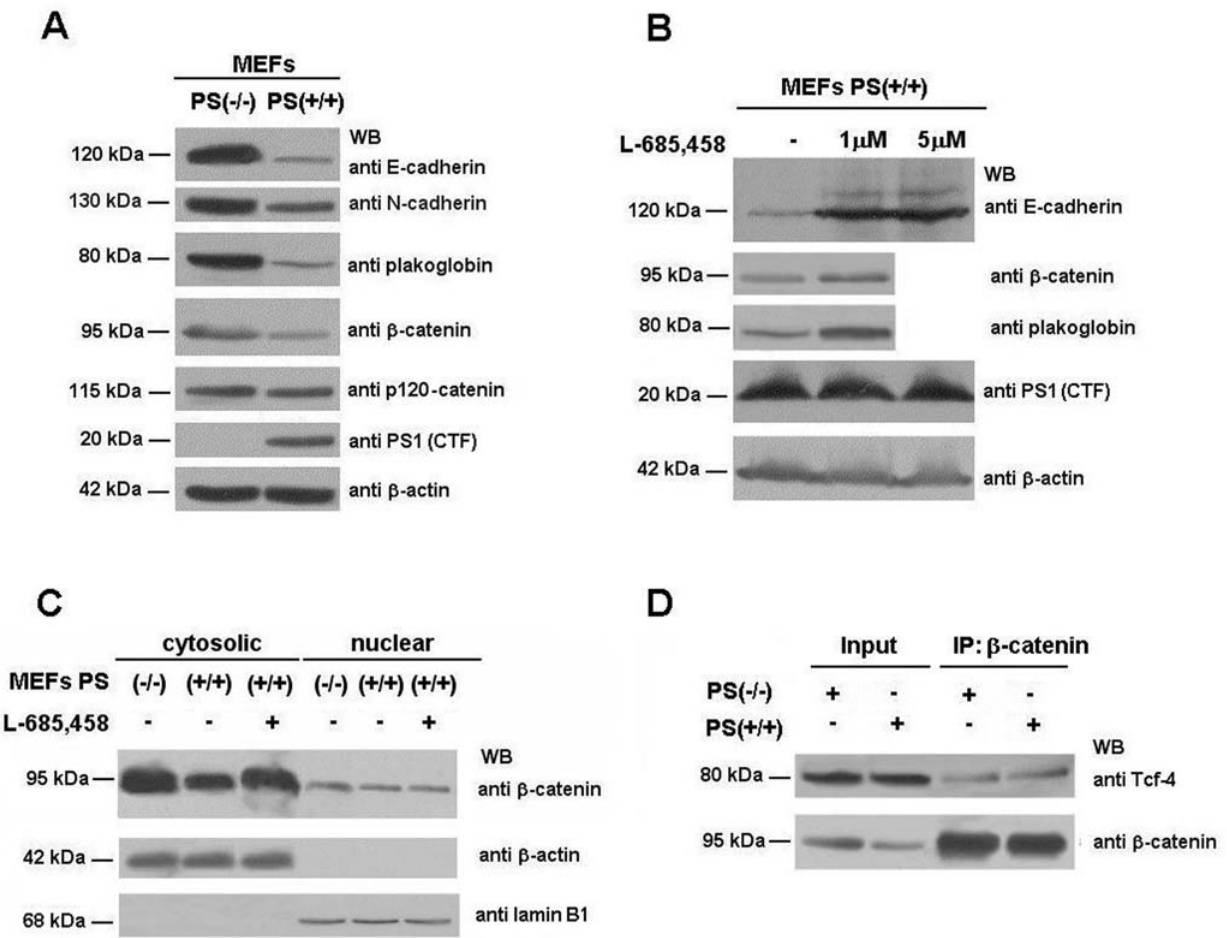
Figure 3. PS depletion increases protein levels of adherens junction-associated proteins. (A) 50 m g of MEF PS ( 2 / 2 ) and PS ( + / + ) total-cell extracts were analyzed by Western blotting with the indicated antibodies. (B) MEF PS ( + / + ) cells were incubated with 1–5 m M c -secretase inhibitor L- 685,458 for 24 h. Then, total cell extracts were prepared as described in Experimental Procedures and analyzed by SDS-PAGE and Western blot with the indicate antibodies. No effect of the c -secretase inhibitor was detected in PS/ 2 / 2 ) cells on the levels of the studied proteins (not shown). (C) Cytosolic and nuclear fractions of MEF PS ( 2 / 2 ) and PS ( + / + ) cells were prepared as described. When indicated, MEF PS ( + / + ) cells were incubated with 5 m M c -secretase inhibitor L-685,458 for 24 h. 50 m g of each fraction was analyzed by Western blotting with anti- b -catenin, anti- b -actin and anti- laminB1. (D) 800 m g of MEF PS ( 2 / 2 ) and PS ( + / + ) total-cell extracts were immunoprecipitated with an anti- b -catenin MAb, and analyzed by Western blot with specific antibodies against Tcf-4 and b -catenin. In the Input lane, a sample corresponding to 7% of the total cell extracts used for the assay was loaded.